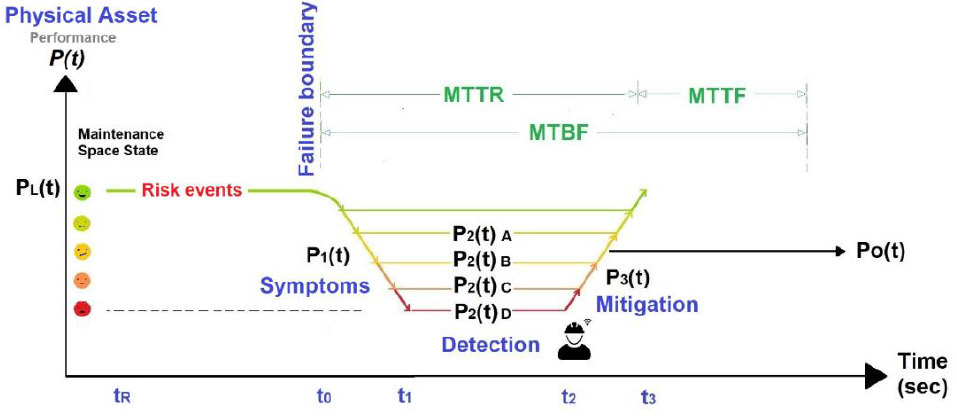
Figure 13. Resilience configuration.